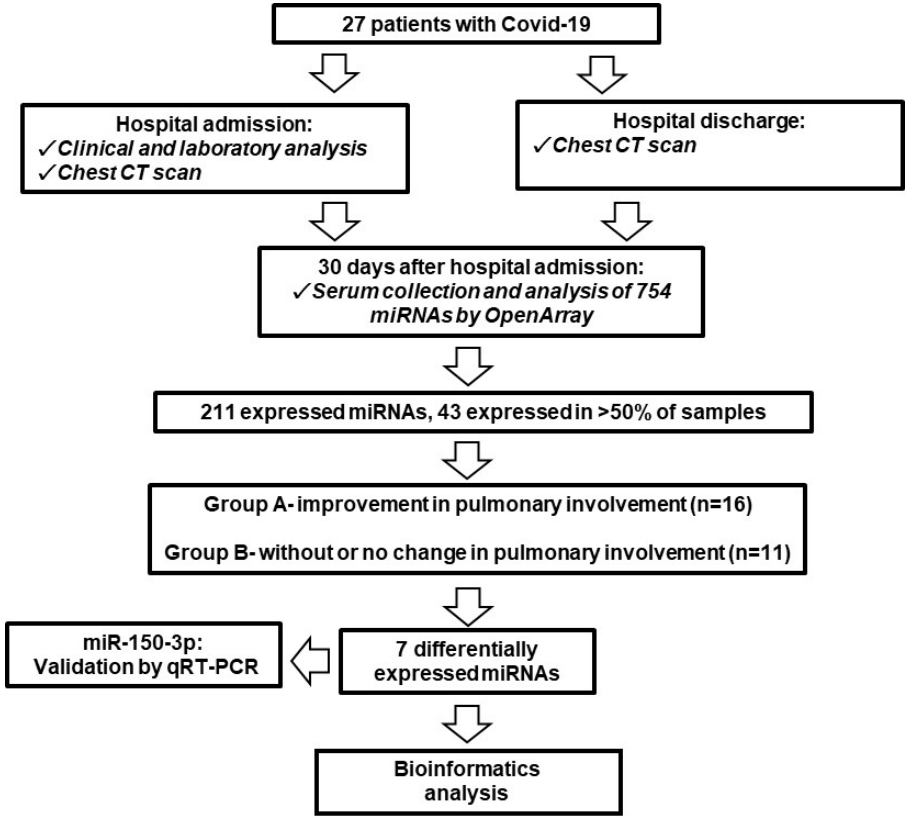
Figure 1. Flowchart illustrating the steps in the study of serum miRNA expression in pulmonary impairment in patients with COVID-19.